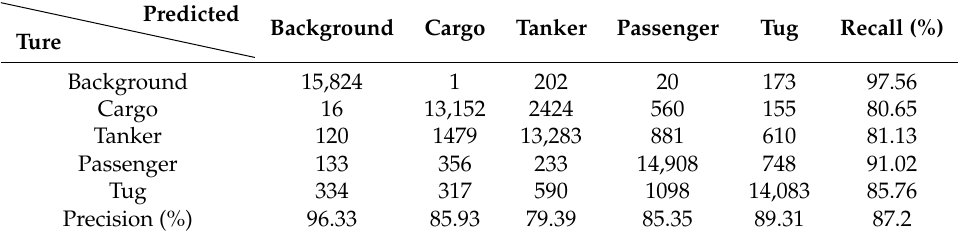
Table 2. Confusion matrix of samples.